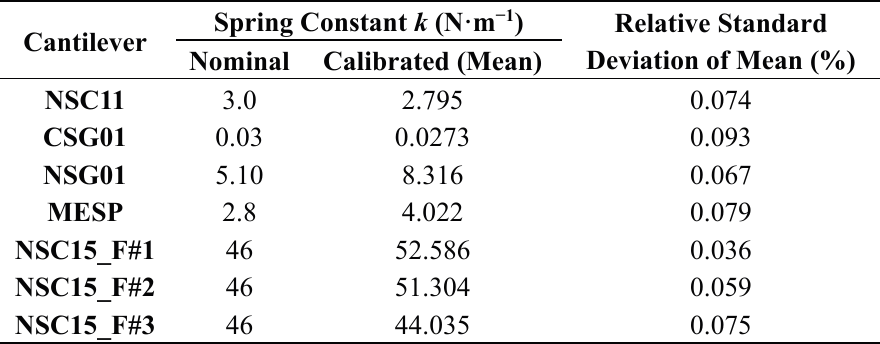
Figure 4. Force calibration curves of NSC11 and NSC15_F#1 cantilever. ( a , b ) are the force-deflection relationships; ( c , d ) are the scatters of measurement results. Table 2. Calibration results of different